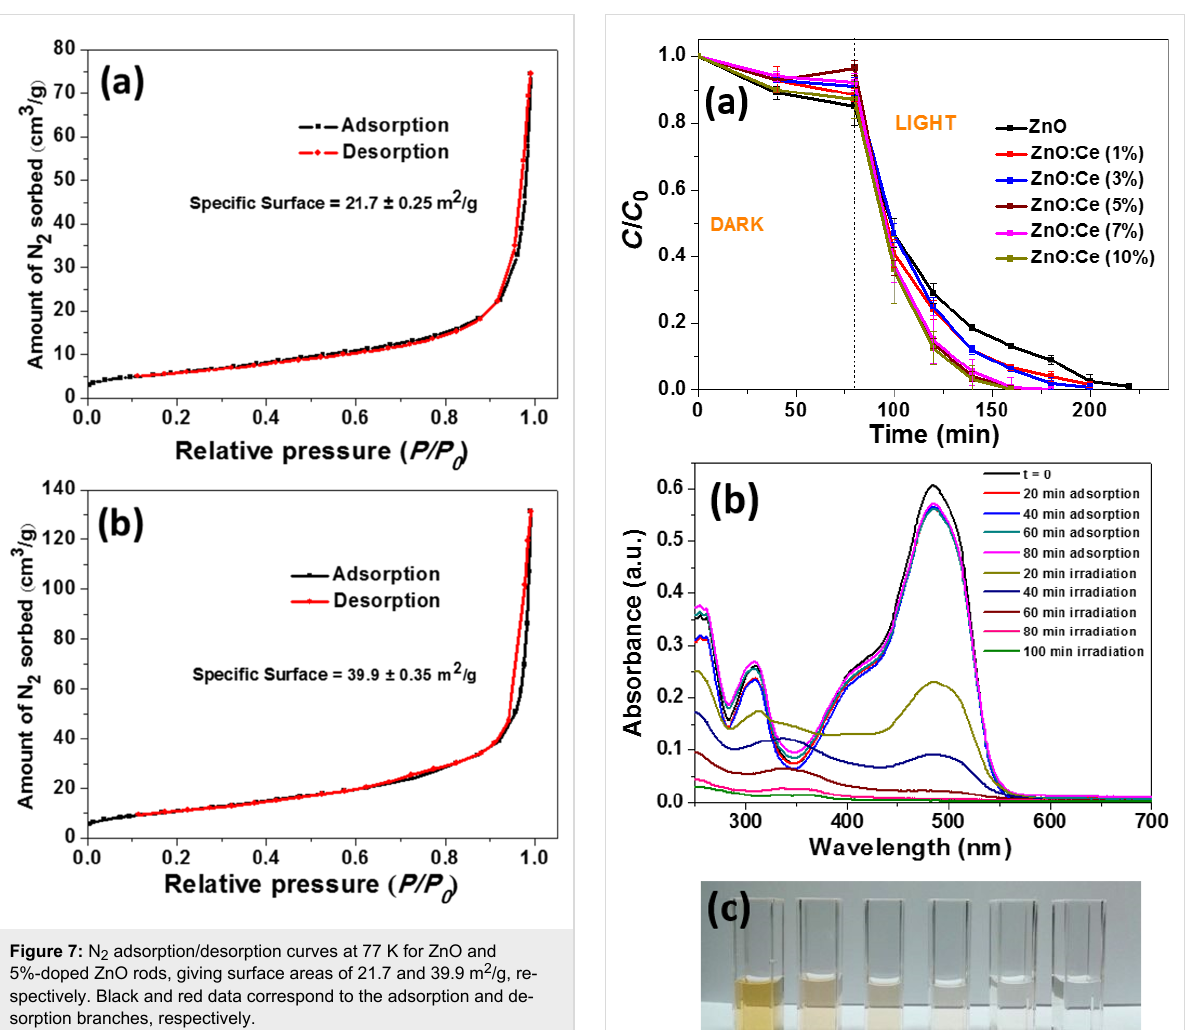
Figure 8: (a) Influence of the doping in Ce of ZnO rods for the degra- dation of Orange II in aqueous solution ( C is the Orange II concentra- tion at time t , and C 0 is the concentration of the dye at t = 0; Volume of solution, 30 mL; Mass of photocatalyst, 30 mg; Orange II concentra- tion, 10 mg/L). (b) Variation of Orange II concentration as a function of irradiation time. (c) Photographs of the Orange II solution during photo-